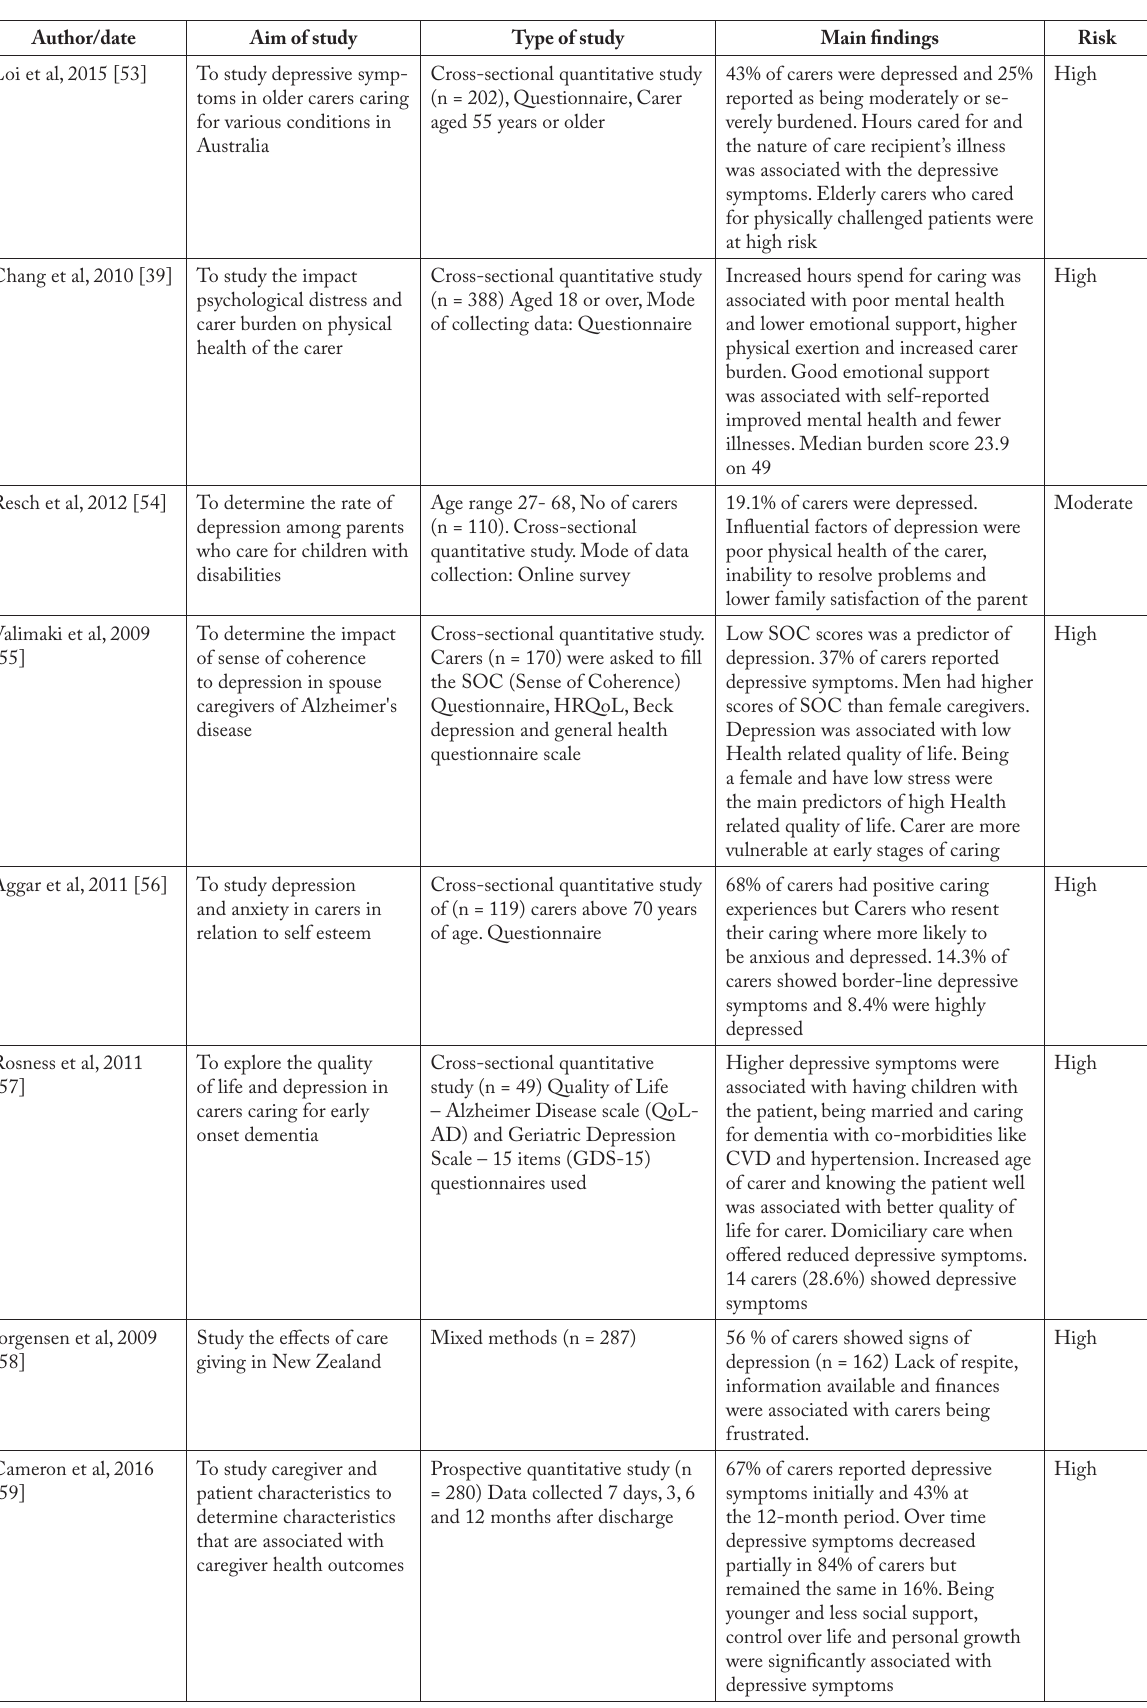
Table 4. Depression among